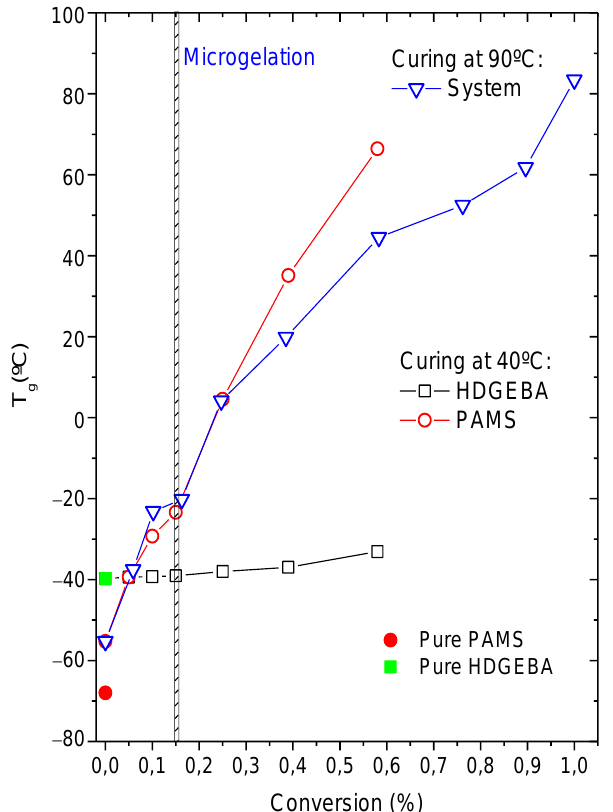
Figure 1. Glass transition temperatures of pure HDGEBA and PAMS and the reactive HDGEBA/PAMS system as a function of epoxy